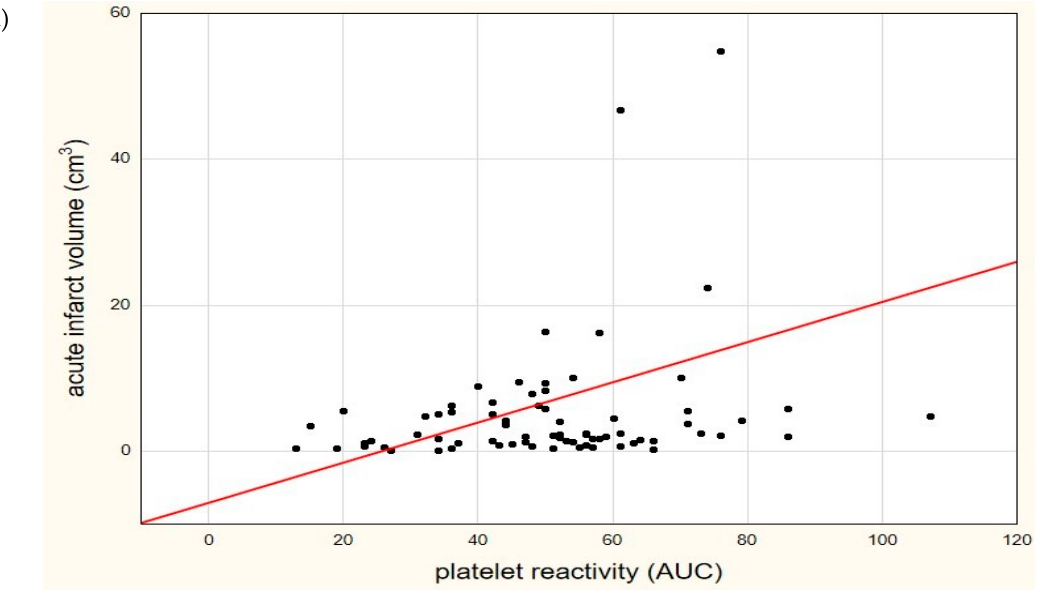
Figure 3. Changes of platelet reactivity over time in relation to the severity of chronic ischemic lesions. ( A ) Significant and favorable changes of platelet reactivity (expressed in area under the curve units—AUC) in stroke subjects with mild se- verity of chronic ischemic lesions (Fazekas scale—1). ( B ) Insignificant and unfavorable changes of platelet reactivity in stroke subjects with moderate severity of chronic ischemic lesions (Fazekas scale—2). ( C ) Insignificant and unfavorable changes of platelet reactivity in stroke subjects with extensive severity of chronic ischemic lesions (Fazekas scale—3).